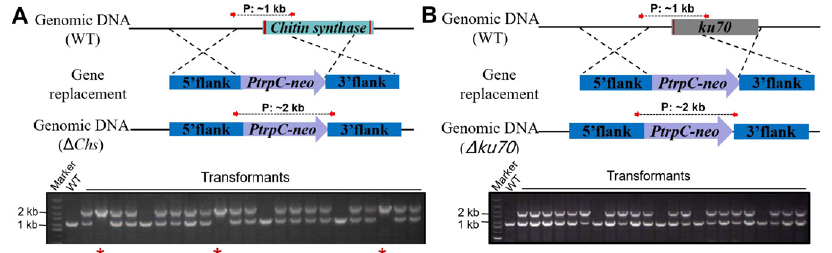
Figure 3. PCR analysis of Chs ( A ) and ku70 ( B ) deletion transformants. The primers located in the 5 ′ flank and 3 ′ flank of the target gene knockout region are shown by red arrows, and the predicted sizes of PCR products in the wild type (~1 kb) and gene knockout mutant (~2 kb) are shown by dashed lines. The ectopic insertion mutant contained both bands (~1 kb and ~2 kb). Electrophoresis images displayed partial results of transformant screening. The confirmed Δ Chs mutants are indicated with red asterisks. Red rectangles in genomic DNA indicate the intron regions of the target gene.